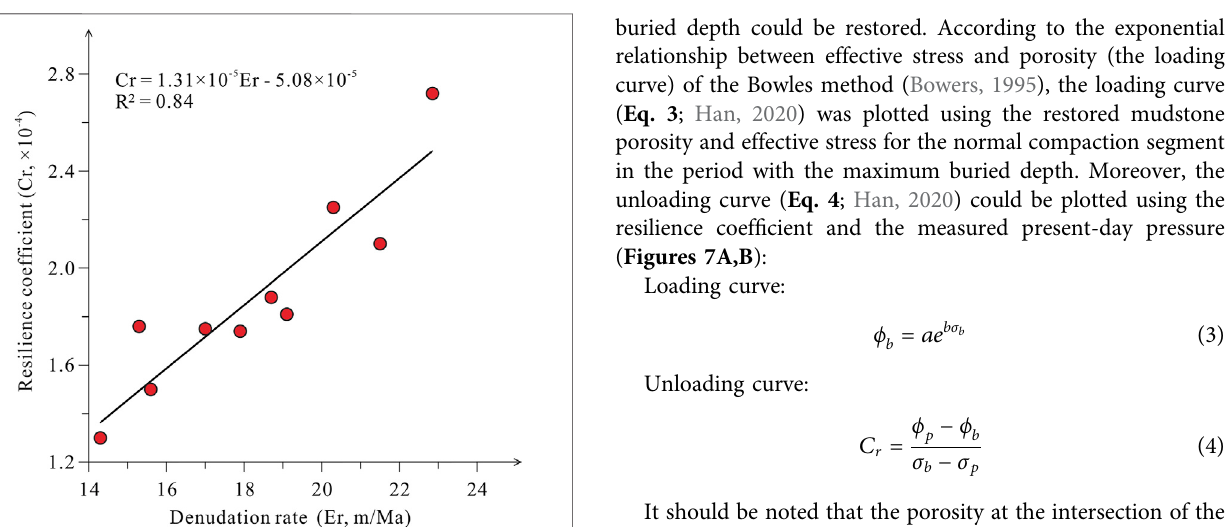
FIGURE 6 | Correlation between the pore resilience coef fi cient and denudation rate of Chang 7 shale samples in the adjacent area of the Longdong